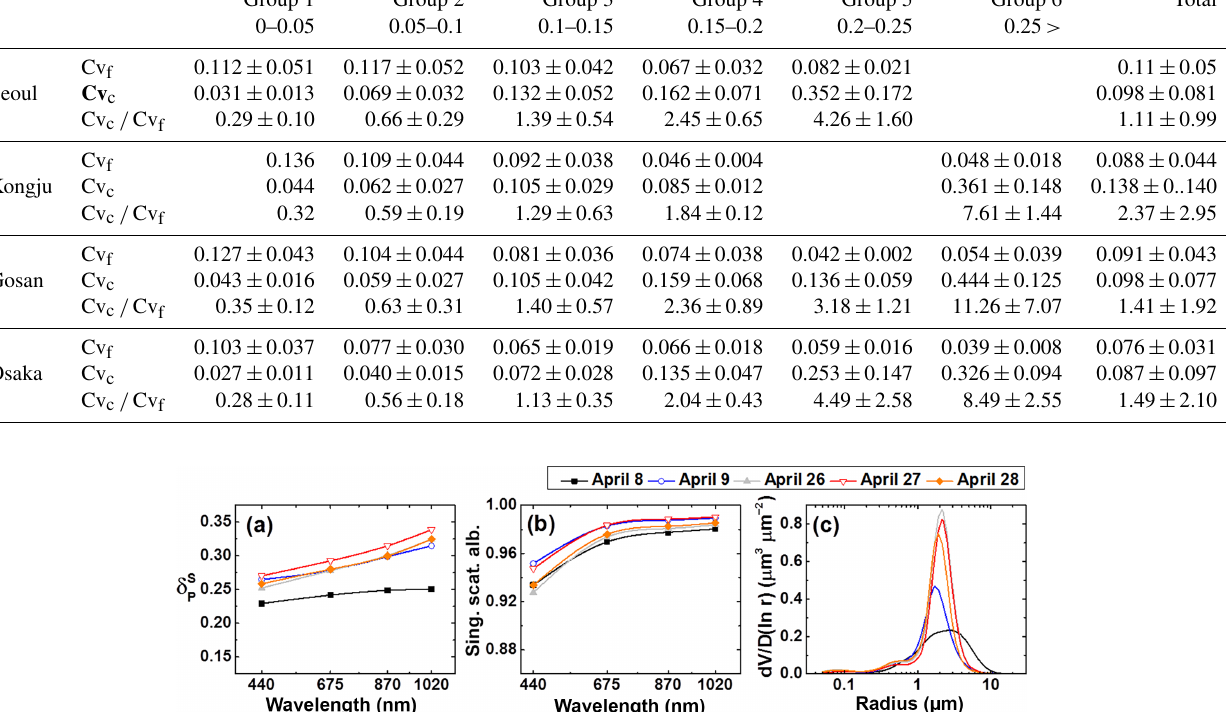
Figure 10. (a) Linear particle depolarization ratios, (b) single-scattering albedos, and (c) volume particle size distributions derived from sun–sky radiometer observations at